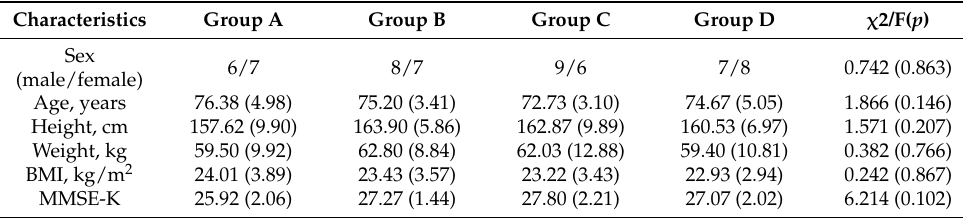
Table 1. Baseline Characteristics of Participants ( N =